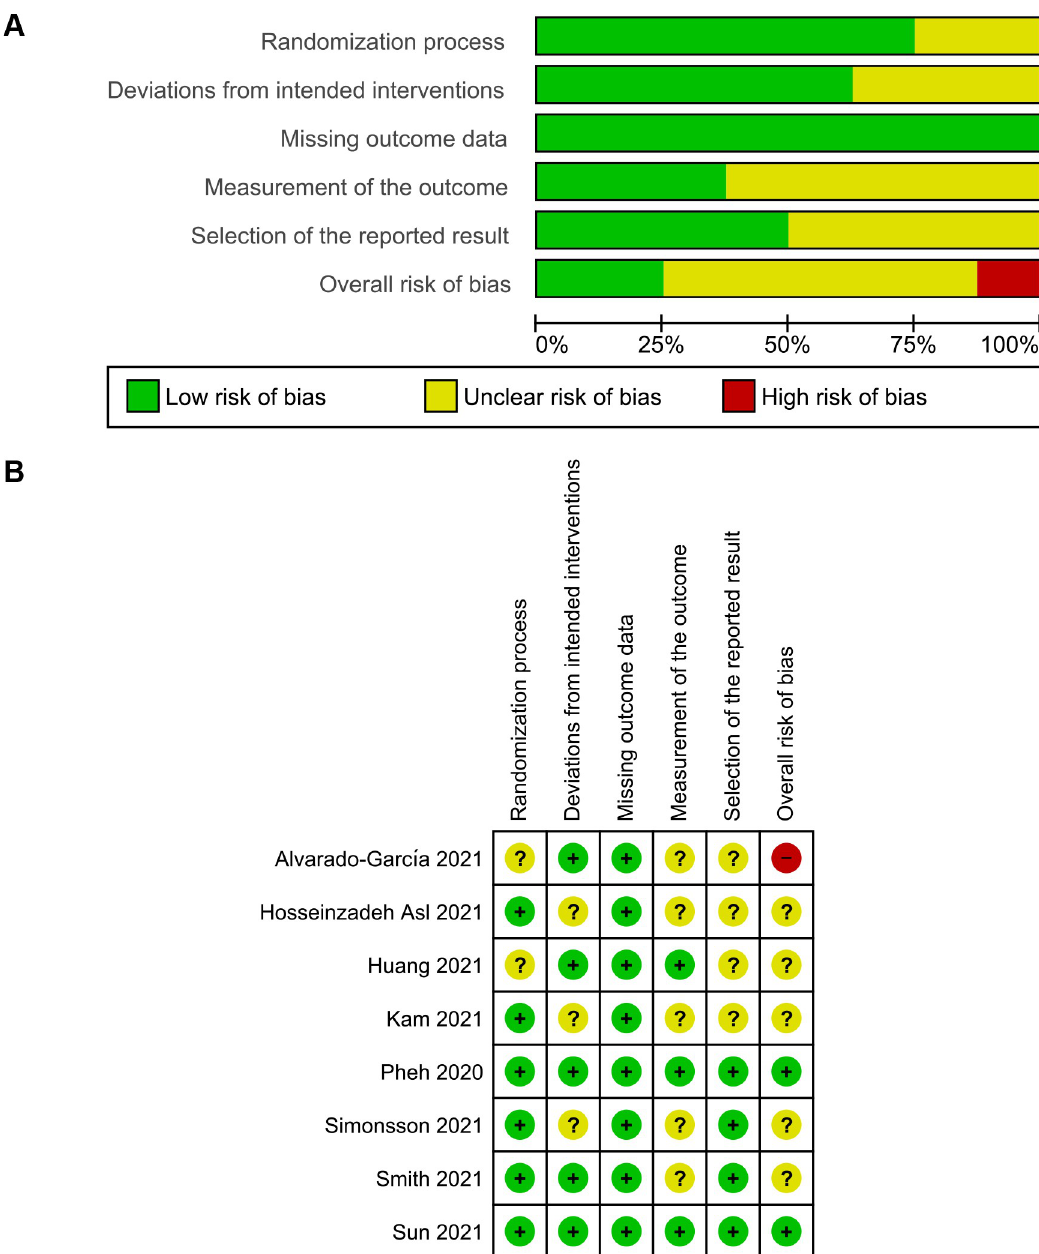
Fig 2. Results of quality assessment of included studies using the Risk of Bias 2 tool. ( A ) Domain-specific quality assessment graph. ( B ) Detailed quality assessment